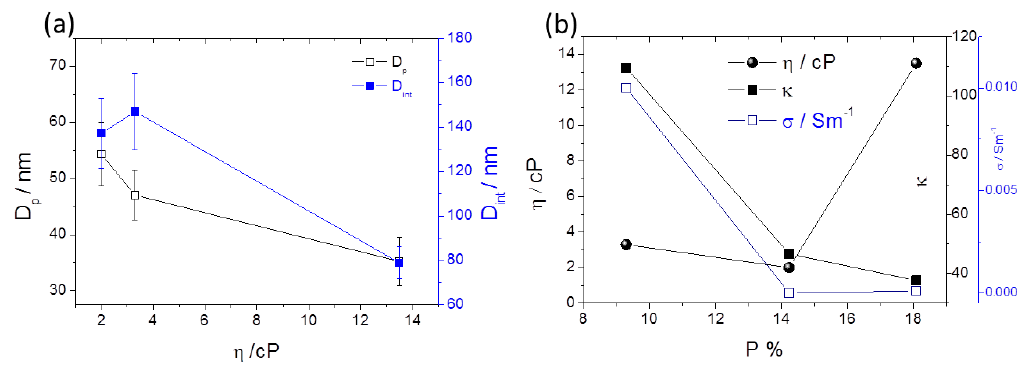
Figure 10. ( a ) D p , D int as a function of the solvent viscosity η and ( b ) η and κ ; σ as a function of the porosity ( P ).